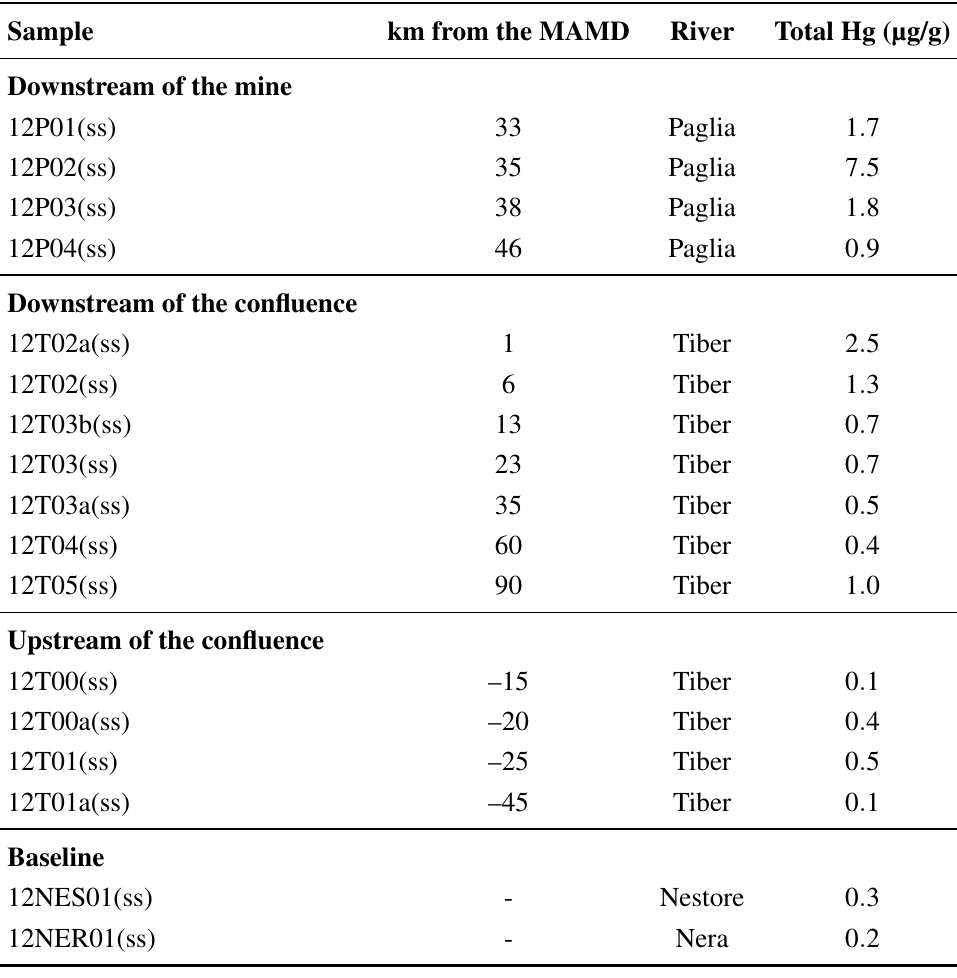
Table 1. Total mercury concentrations for stream sediment (ss) collected along Paglia and Tiber rivers during the September 2012, campaign. Samples are ordered from the nearest to the farthest from the Mount Amiata mining district